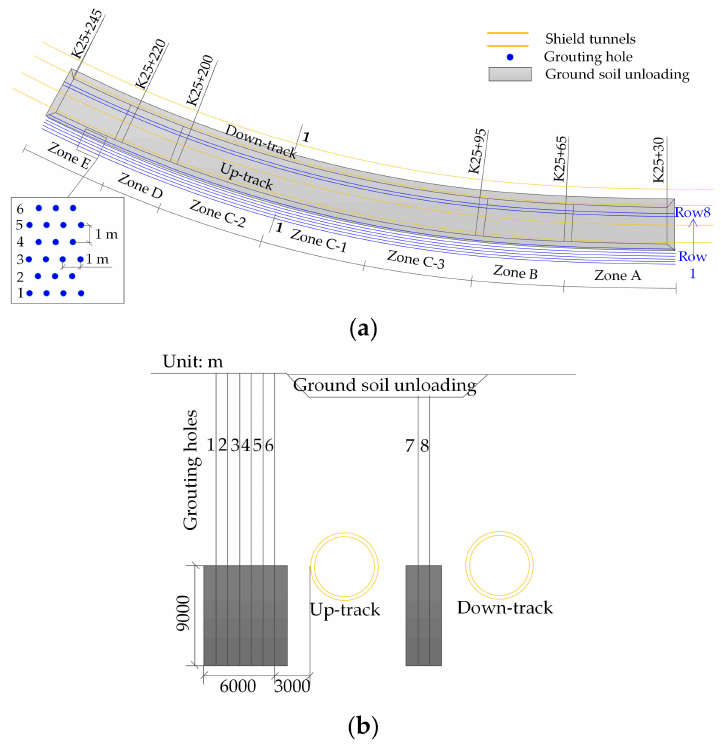
Figure 2. Scheme of the remediation project. ( a ) Plan view; ( b ) typical profile.